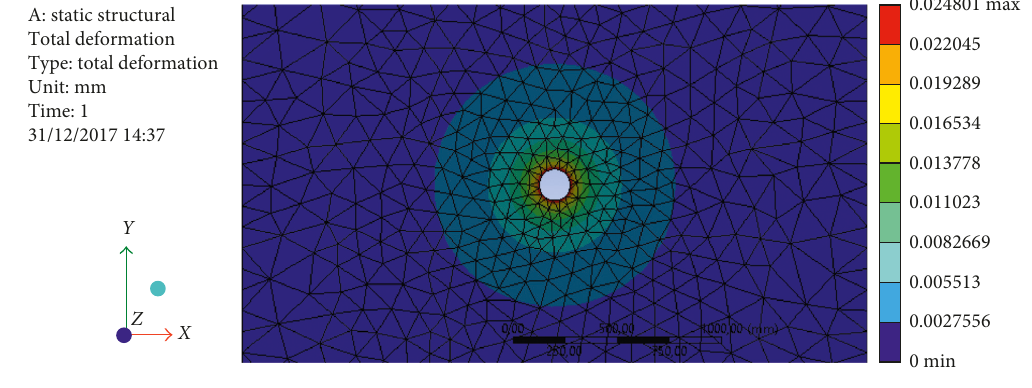
Figure 5: Redistribution of displacement.